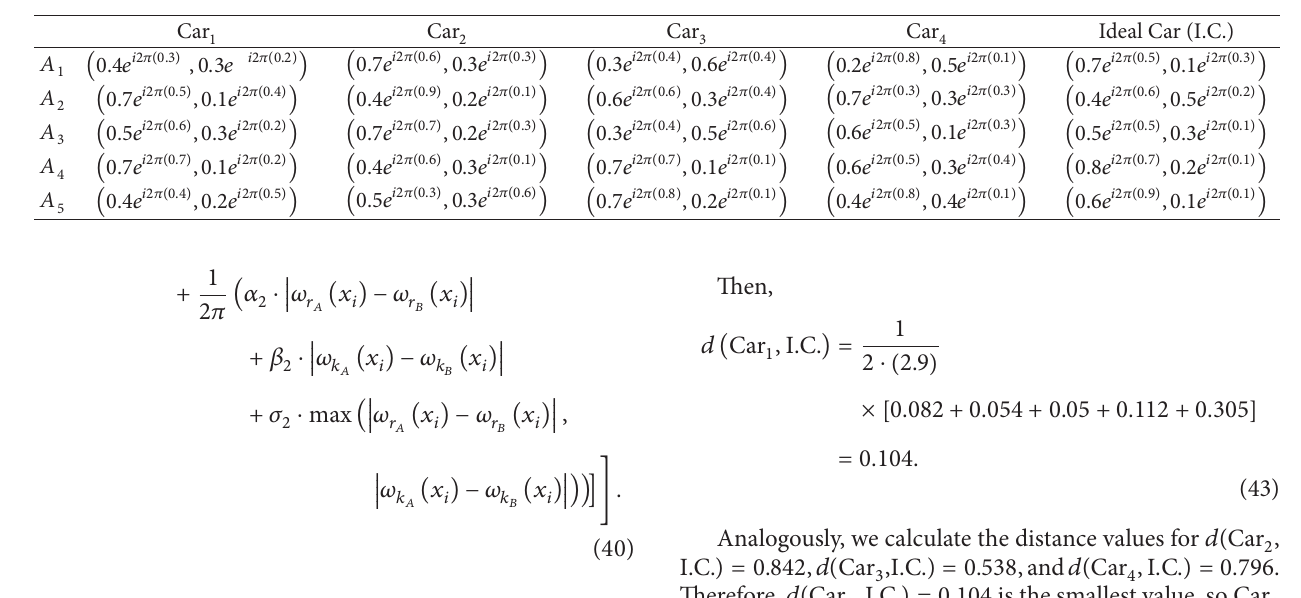
Table 1: Car data and the ideal